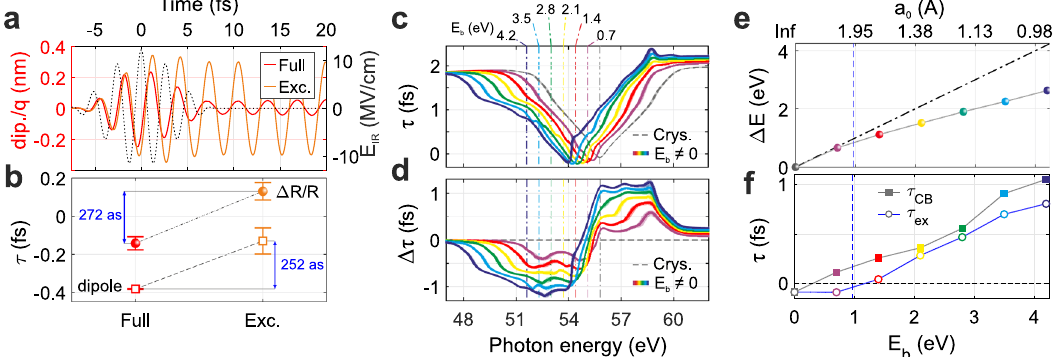
Fig. 4 Exciton real space dynamics and role of localisation. a Exciton dipole oscillations in real time computed with the full (red) or pure exciton (orange) model. The black-dotted curve represents the IR electric fi eld. b Comparison of the phase delay extracted from Δ R / R (circles) or from the dipole moment (squares) for the full calculations (red) or considering only the excitonic response (orange). c Behaviour of the calculated phase delay τ as a function of the exciton binding energy E b . The vertical dash-dotted lines mark the exciton position. d Difference between the phase delay of the full system and the pure- crystal response, Δτ , for the data reported in ( c ). e Energy shift Δ E which minimises Δτ as a function of E b (Bohr radius a 0 ). The vertical blue dashed line marks the minimum inter-nuclear distance in the MgF 2 crystal unit cell equal to 1.98 Å. f Value of the phase delay τ evaluated at the exciton vertical transition ( τ ex , open circles), or at the bottom of the CB ( τ CB , full squares) for the different values of E b ( a 0 )